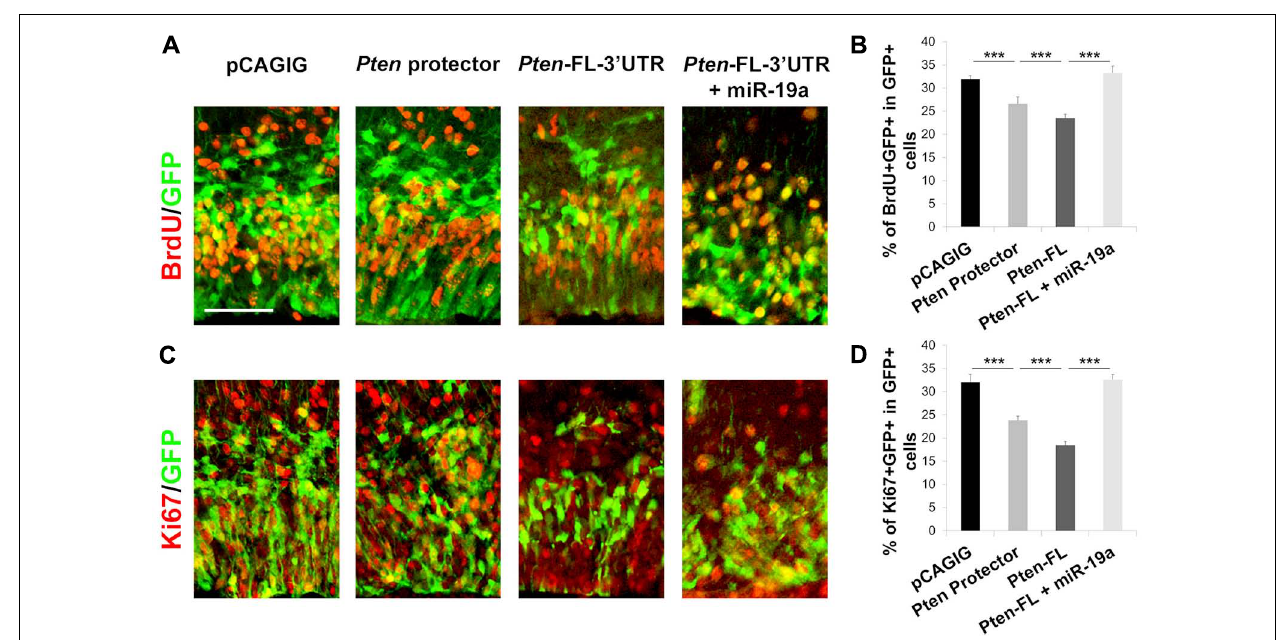
Pten containing the 3 (cid:2) UTR ( Pten-FL-3 (cid:2) UTR ) showed a similar effect, while co-electroporation of Pten-FL-3 (cid:2) UTR and miR-19a ablated this effect. Data are presented as mean ± SD; n ≥ 3 for all electroporations; p values in relation to control (*** p < 0.001). Scale bar: 50 μ m.